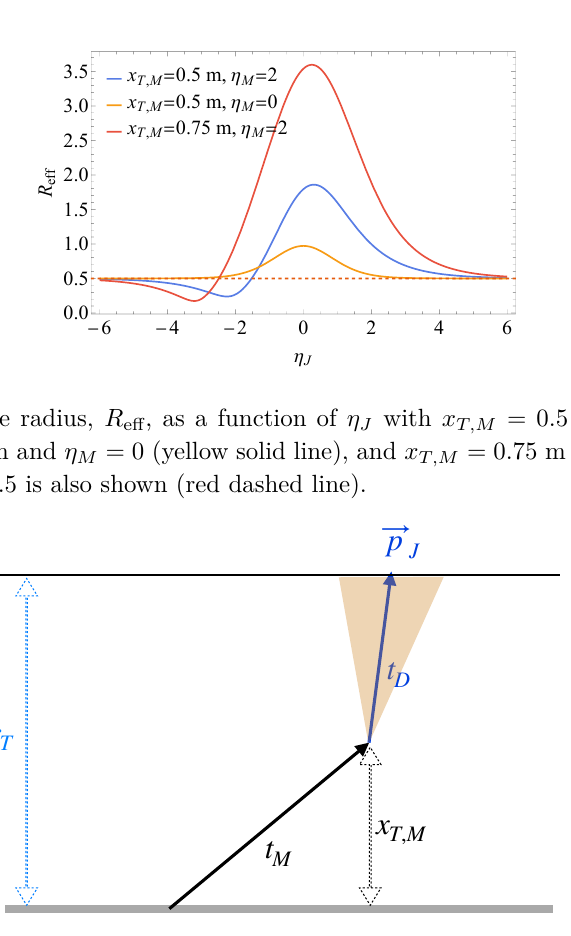
Figure 6 . The time of flight of the mother particle is t M and the time of flight of a daughter particle is t D